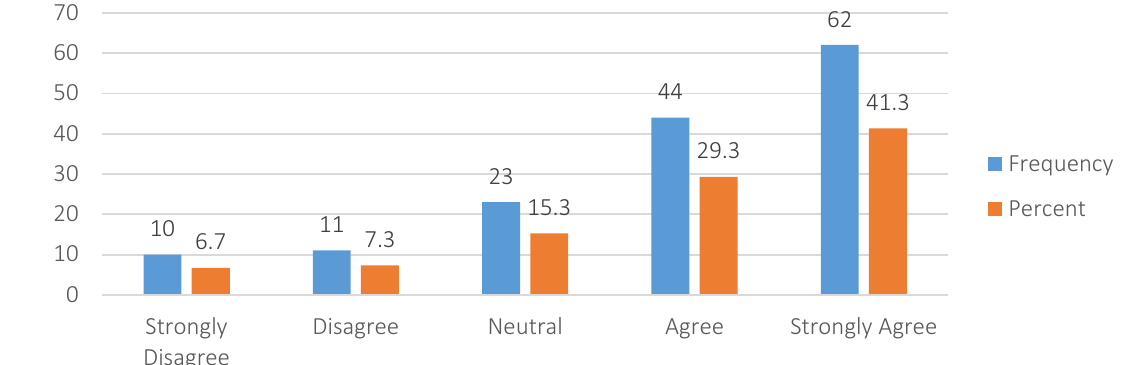
Figure 7. The inability to adopt MAPs impedes on business innovation